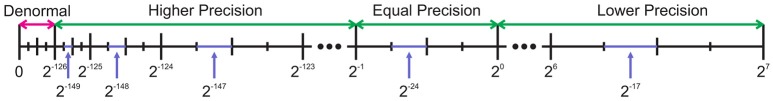
Comparing gaps between two adjacent numbers for a single-precision floating-point number and a 32-bit fixed-point number. The fixed-point number has 24 fractional bits. The positive side is displayed. While the single-precision number has higher or equal precision for values below one, it shows lower precision for other values.